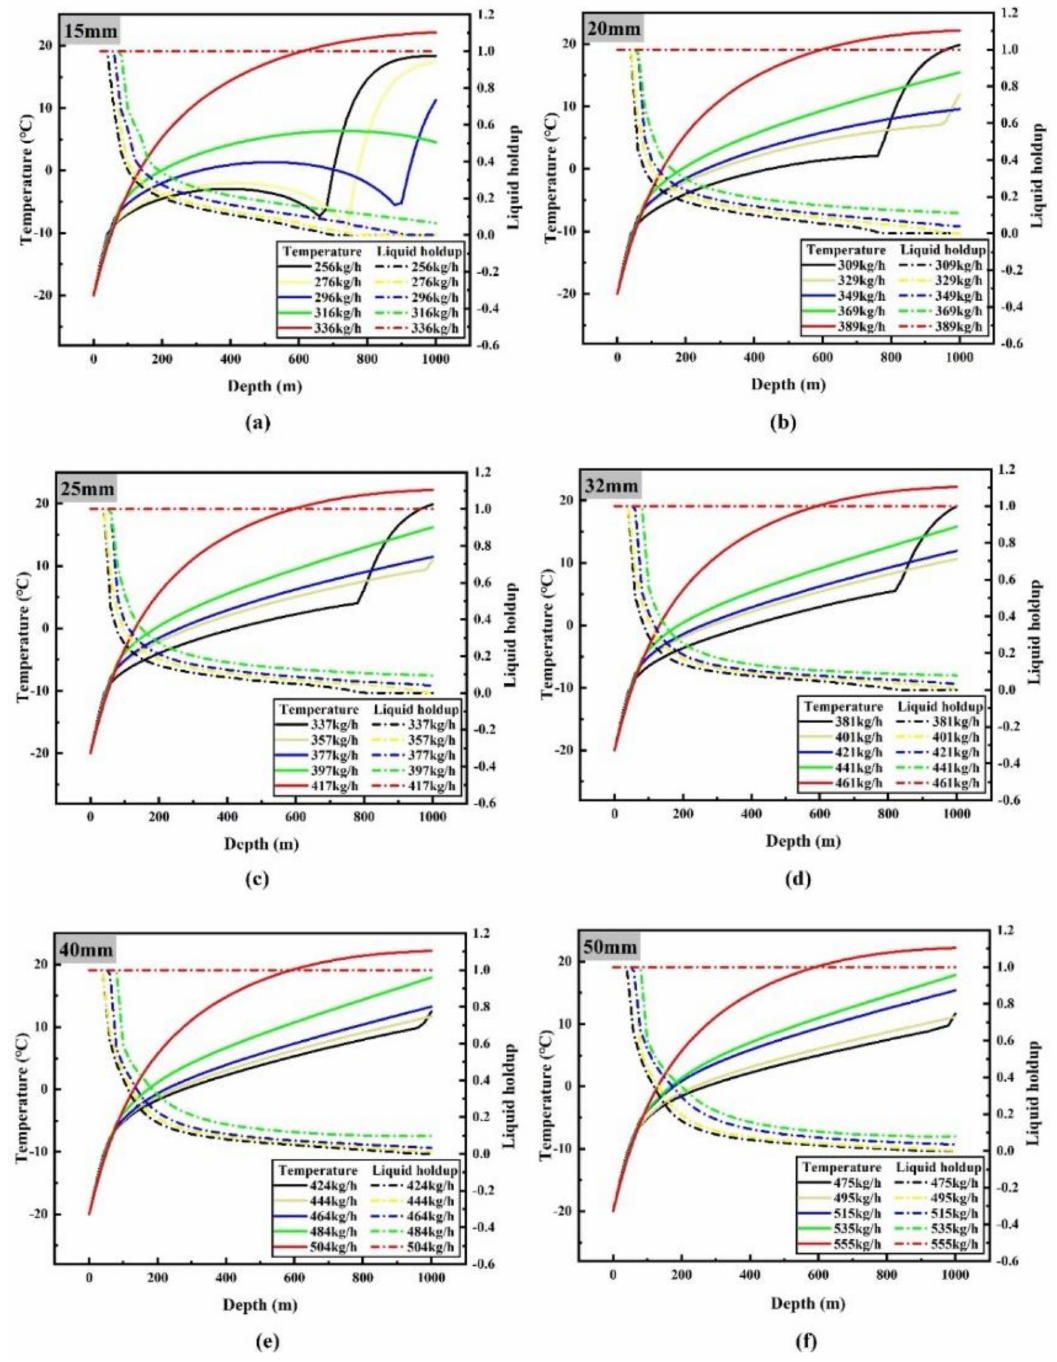
Figure 6. Variations of temperature (solid line) and liquid holdup (dotted line) along the pipeline when the flow rate is less than or equal to the minimum limit flow rate: ( a ) 15 mm diameter; ( b ) 20 mm diameter; ( c ) 25 mm diameter; ( d ) 32 mm diameter; ( e ) 40 mm diameter; ( f ) 50 mm